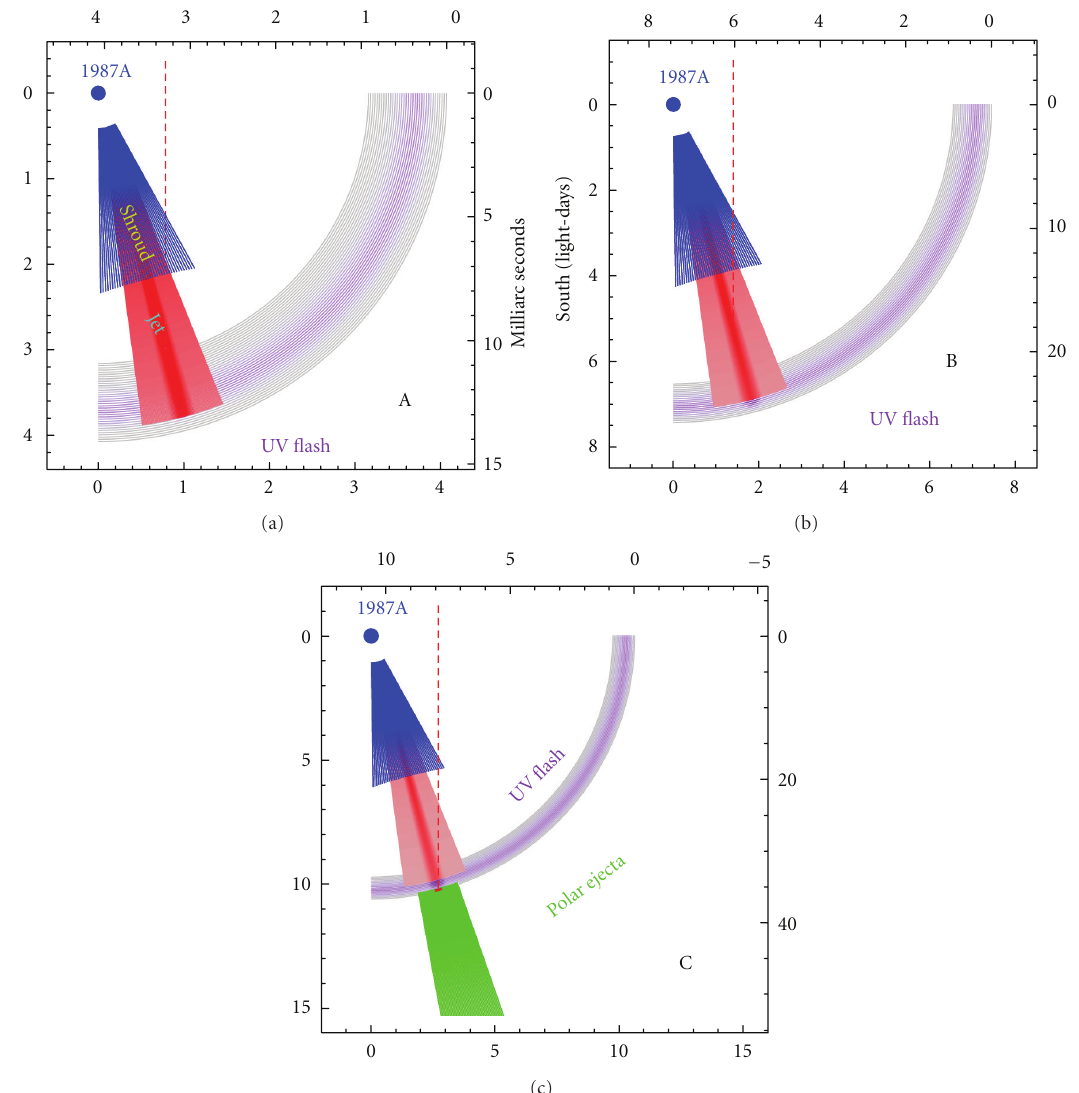
Figure 4: The geometry of the 1987A-glowing beam/jet, initially opaque shroud, and UV flash (which may have an enhanced beam of its own in the jet direction here 75 ◦ , down and to the right). The maximum velocity of the jet/shroud is 0.95/0.55 c. The dashed line to the upper scale flags the center of the emerging jet at day 3.3 ((a)—A) and day 6 ((b)—B), and the UV flash hitting the polar ejecta at day 7.8